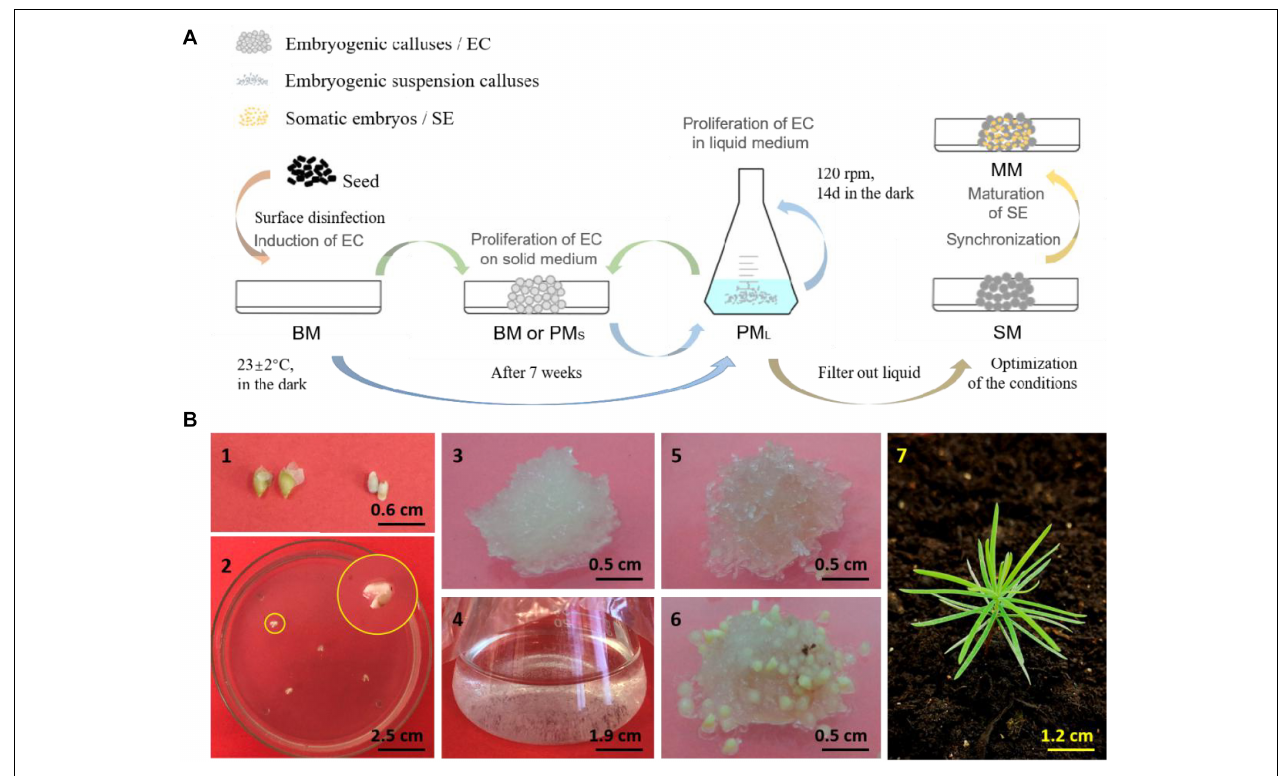
FIGURE 1 | Somatic embryogenesis and regeneration of embryogenic callus of L. olgensis . The schematics (A) of somatic embryogenesis of L. olgensis . Representative images of the (B) immature seeds (1) exfoliated from megasporophyll and (2) inoculated into the basic medium (BM) to induce callus formation, (3) embryogenic callus (EC) cultured on proliferation medium (PM S ) for 14 days, (4) EC cultured in liquid proliferation medium (PM L ) for 7 days, (5) EC cultured on synchronization medium (SM) for 14 days, (6) induction of pro-embryo maturation on maturation medium (MM) for 15 days, and (7) plantlet from somatic embryo